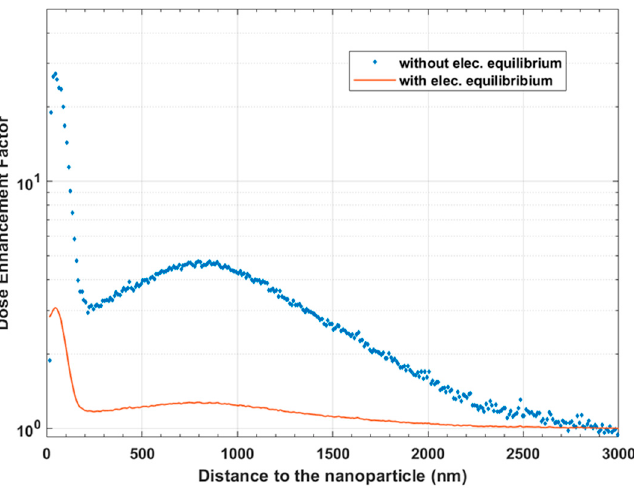
Figure 8. Dose-Enhancement Factor according to the distance to the nanoparticle, considering or not considering the electronic